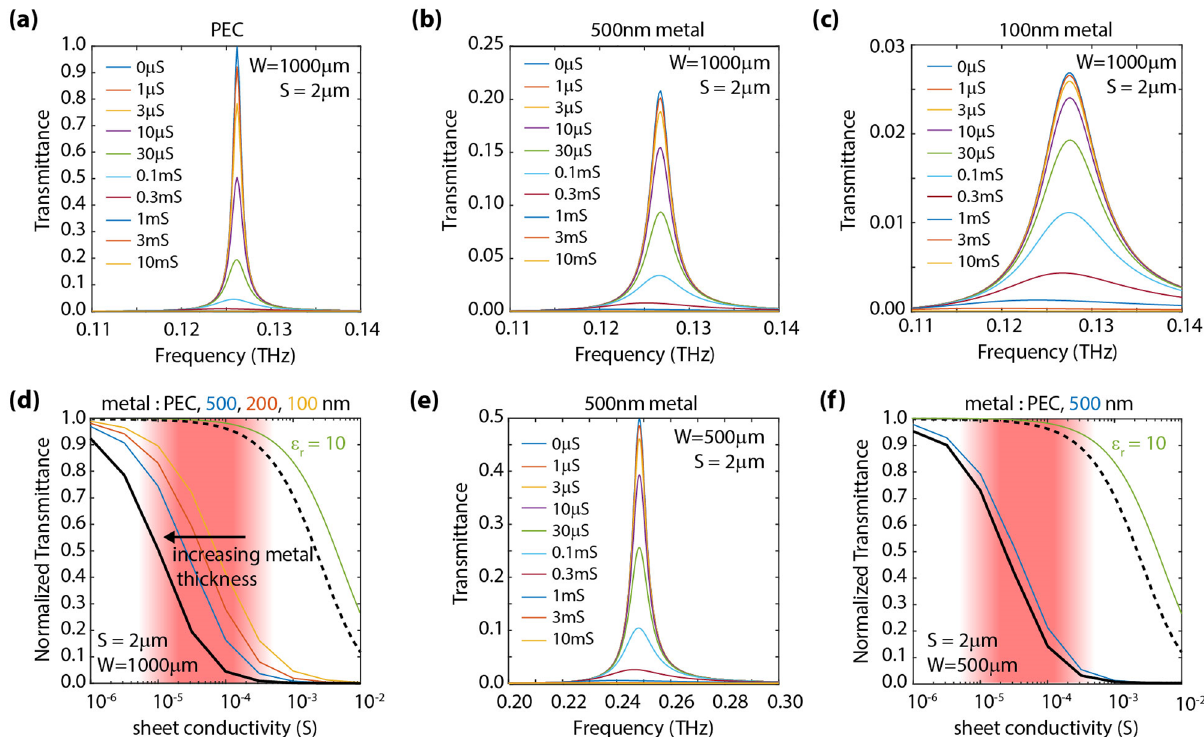
Figure 7. Analysis of sensitivity considering the combined effect of metal losses and the presence of a substrate. ( a–c ) Simulated transmittance spectra when varying sheet conductivity when employing a grating with W = 1000 µm and S = 2 µm. Panels ( a – c ) correspond to: ( a ) PEC, ( b ) 500 nm metal, and ( c ) 100 nm metal, respectively. ( d ) Normalized transmittance (at resonance, i.e., ~ 0.13 THz) versus sheet conductivity. The dashed black curve and continuous green curves correspond to the cases depicted in Fig. 5b; the continuous black curve corresponds to PEC while the continuous blue, orange, and yellow curves correspond to gold metal of different thicknesses. Increasing the metal thickness shifts the characteristic curves towards lower conductivity levels. ( e ) Transmittance spectra when varying sheet conductivity when employing a grating with W = 500 µm and S = 2 µm. ( f ) Normalized transmittance (at resonance, i.e., ~ 0.25 THz) versus sheet